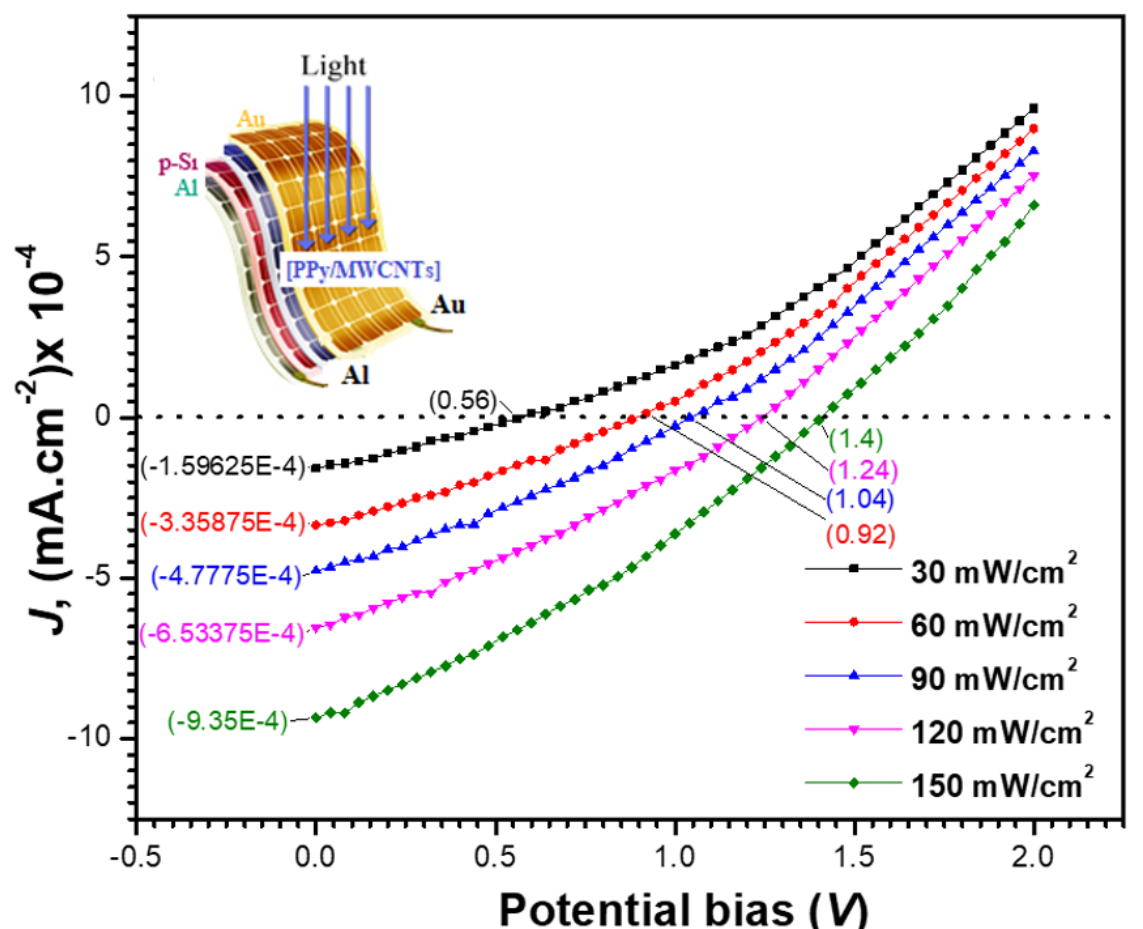
Figure 11. Potential bias dependence of the calculated current density under different illumination intensities. Insert is the design of the fabricated polymer solar energy.